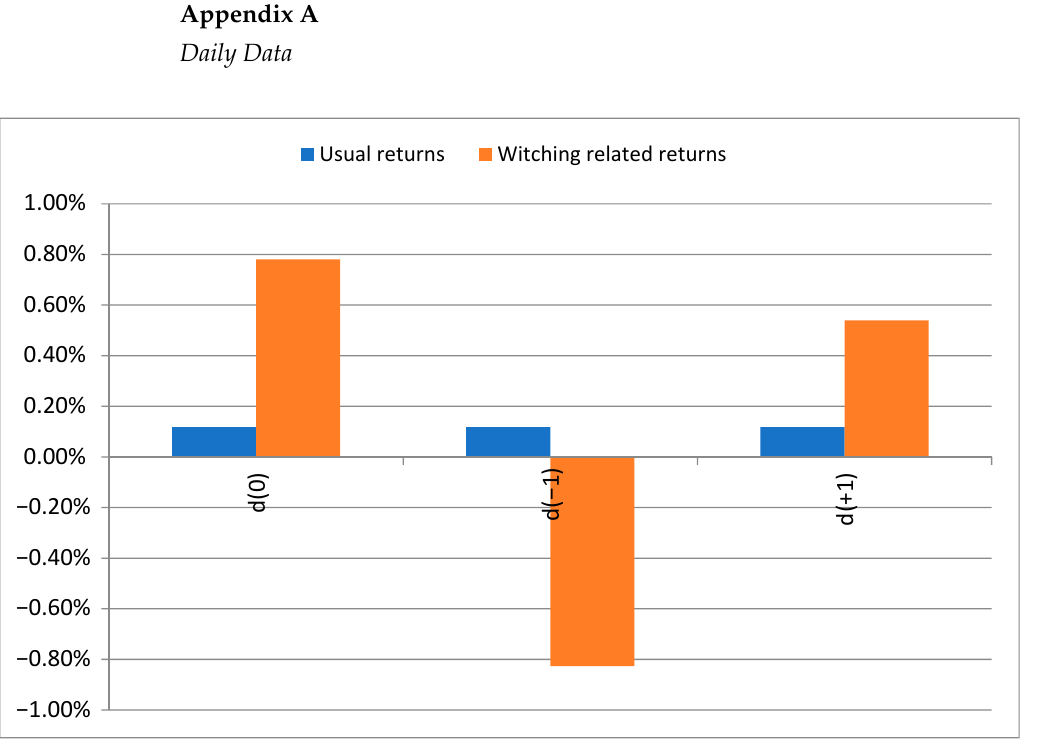
Figure A1. Average returns for the usual days and expiration-related days.